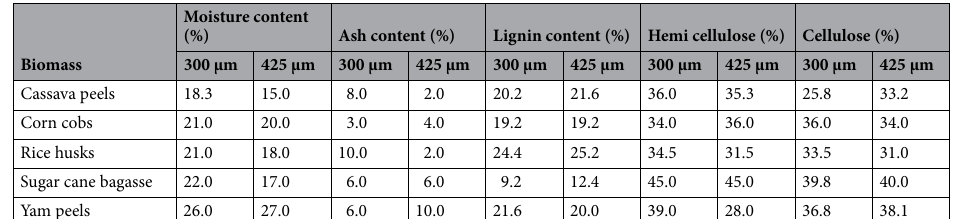
Table 1. Proximate analysis result for unpretreated (raw) biomass samples.